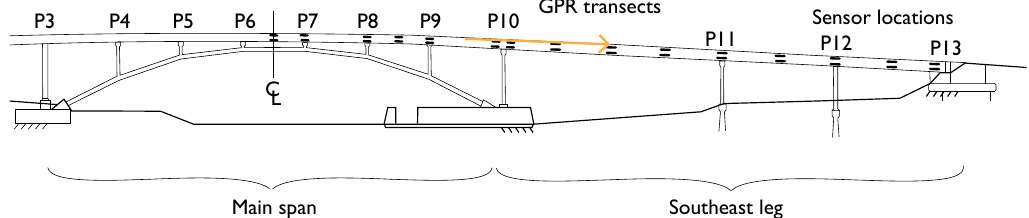
Figure 2. Elevation view of locations of parallel sensors along the main span and southeast leg of Streicker Bridge.